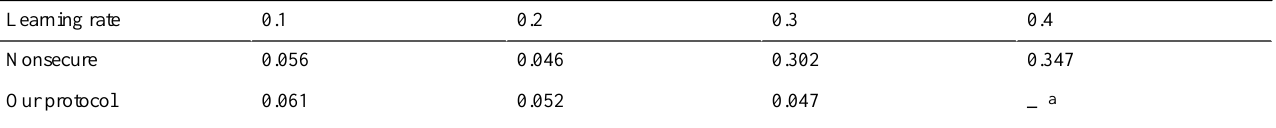
Table 4. || β new– β old|| ÷ || β new|| after 99 iterations (surveillance, epidemiology, and end results colorectal cancer data).